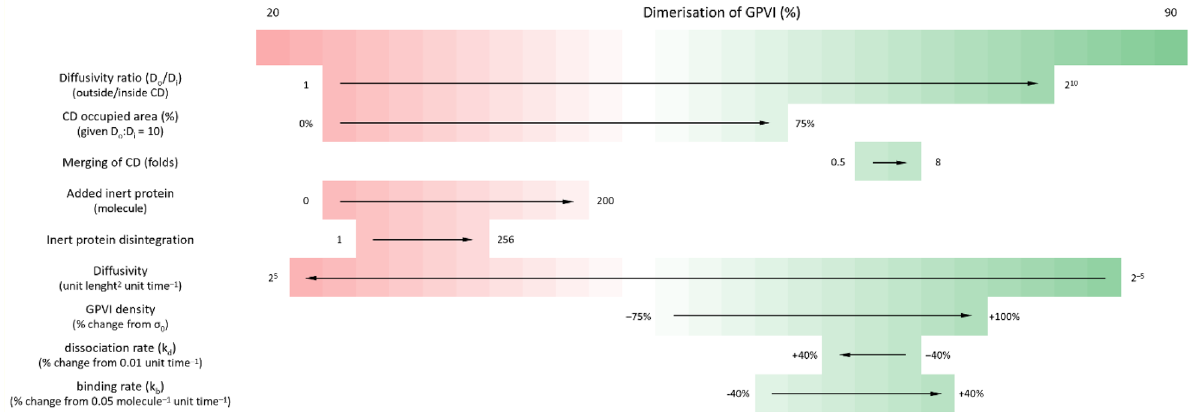
Figure 13. Relative contributions of various modelled factors to GPVI dimer formation. Arrows show the direction of increasing the indicated factor. Other conditions were assumed to be fixed, when varying the parameter of interest. The level of dimerisation (in %) displayed in colour scale: from 20% (red) to 90% (right). Numbers indicate parameter ranges tested with units or dimension indicated in